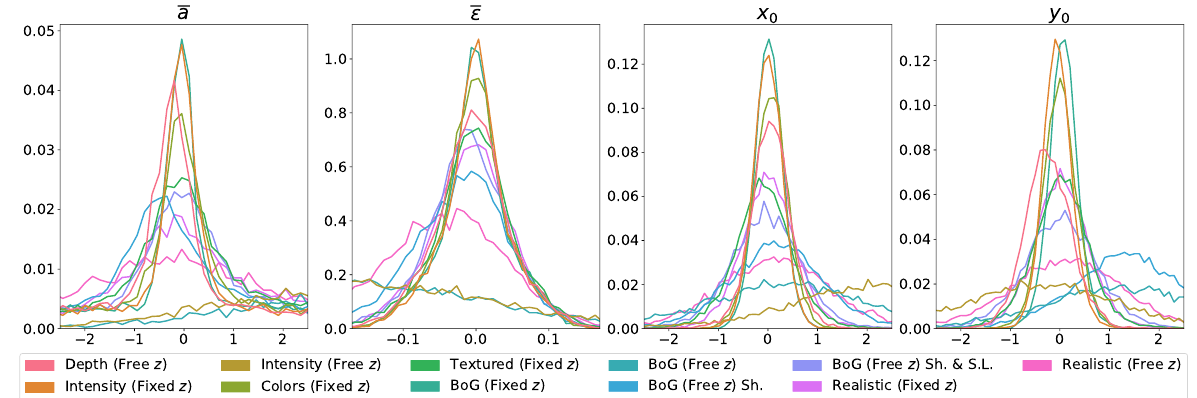
Figure 7. Visualization of mean absolute error (MAE) distributions across the predicted parameters. Each trained model is represented by its own color. Size ( a ) and shape ( (cid:101) ) errors are averaged over all elements of the parameter group, due to the arbitrary ordering discussed before. Errors of the z parameter are not reported, because the distributions serve no purpose for most models, due to the Fixed z